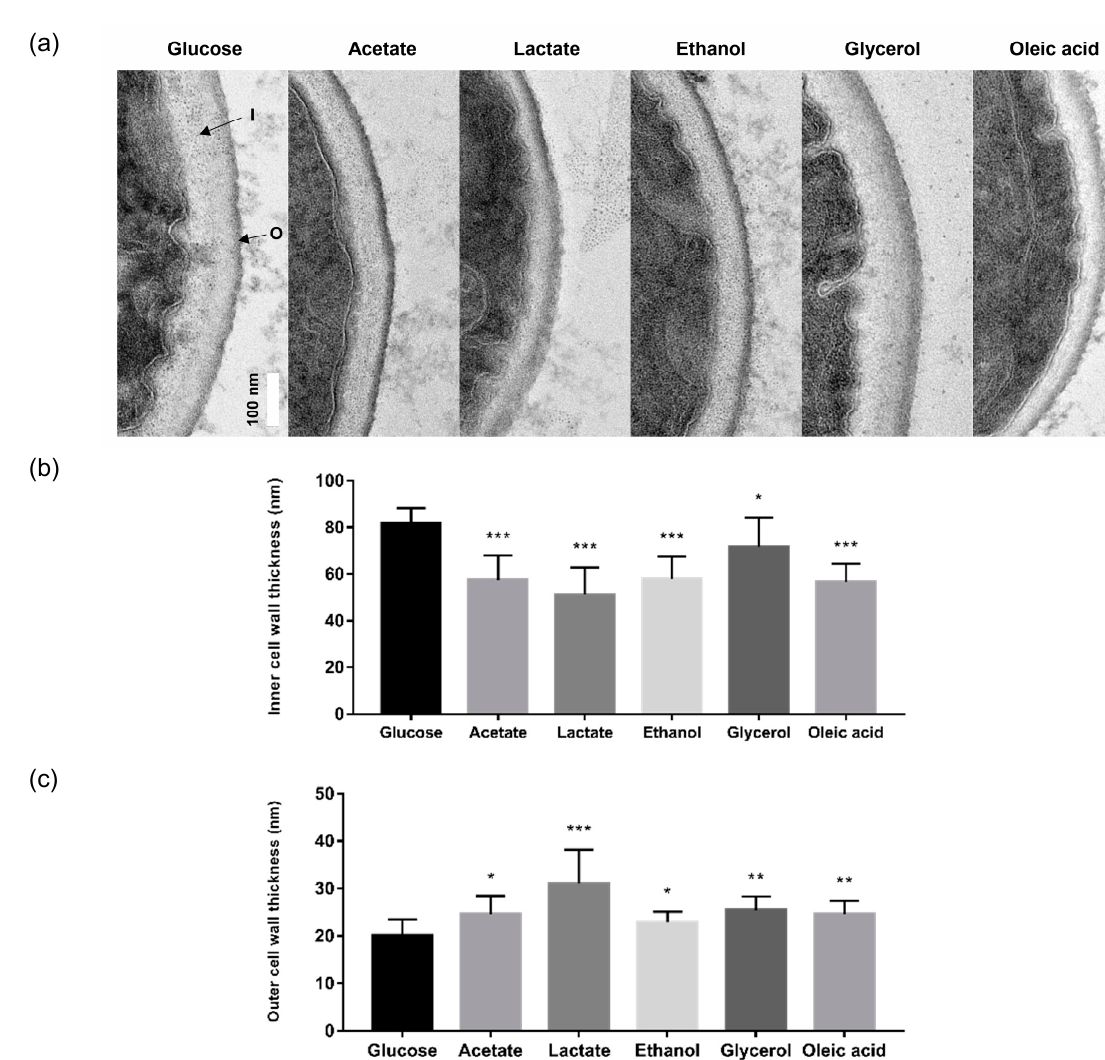
Figure 3. Alternative carbon sources alter the ultrastructure of the C. glabrata cell wall. ( a ) Representative transmission electron microscopy (TEM) images of cell wall architectures from C. glabrata grown on glucose and alternative carbon sources, [I] indicates inner cell wall layer ( β -glucan and chitin) and [O] indicates outer cell wall layer (mannan). Scale bar represents 100 nm. ( b ) Quantification of thickness of the inner cell wall. ( c ) Quantification of the thickness of the outer cell wall. Results are presented as means ± SD from 10 individual cells by averaging 20 measurements obtained from the cell periphery of each C. glabrata cells. * p < 0.05, ** p < 0.01 and *** p < 0.001 were considered statistically significant relative to glucose-grown cells.